Question: What kind of plot is shown here?
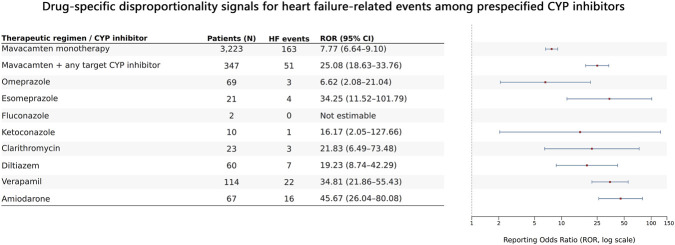
Answer: forest